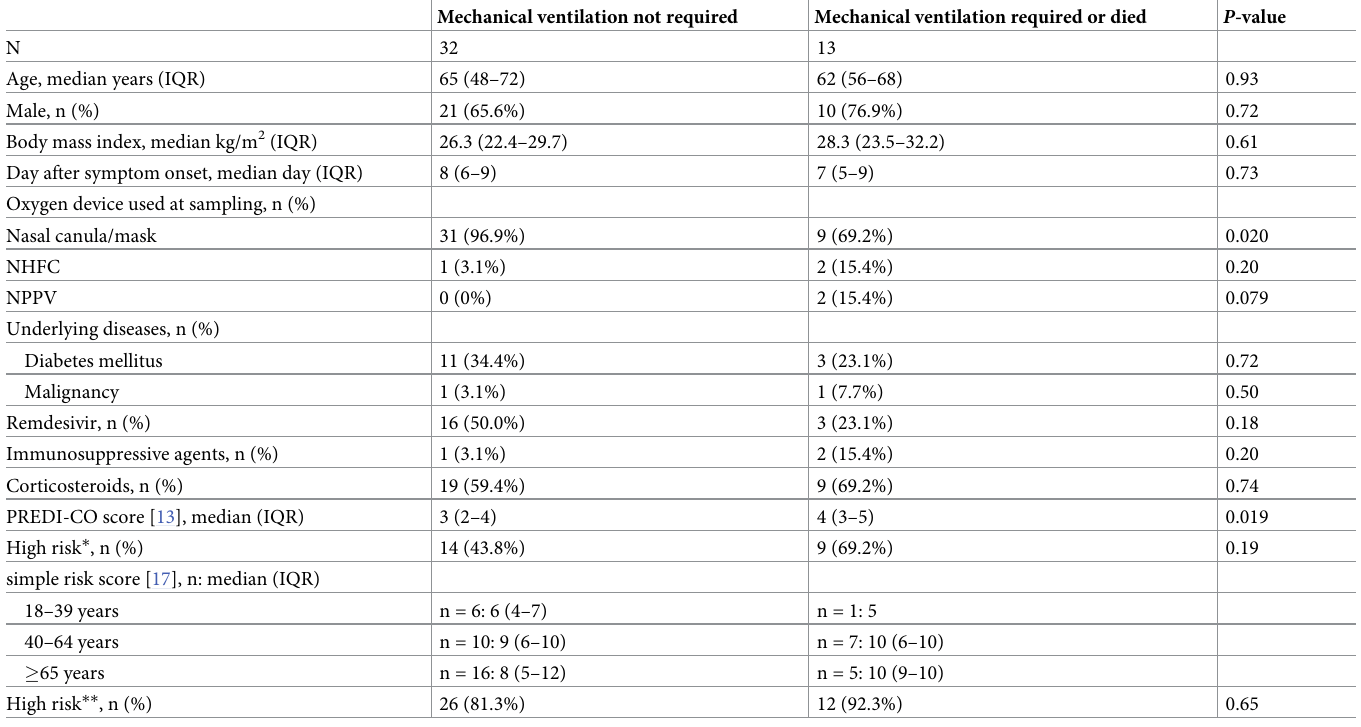
Table 3. Patient characteristics at serum sampling in Study 2.